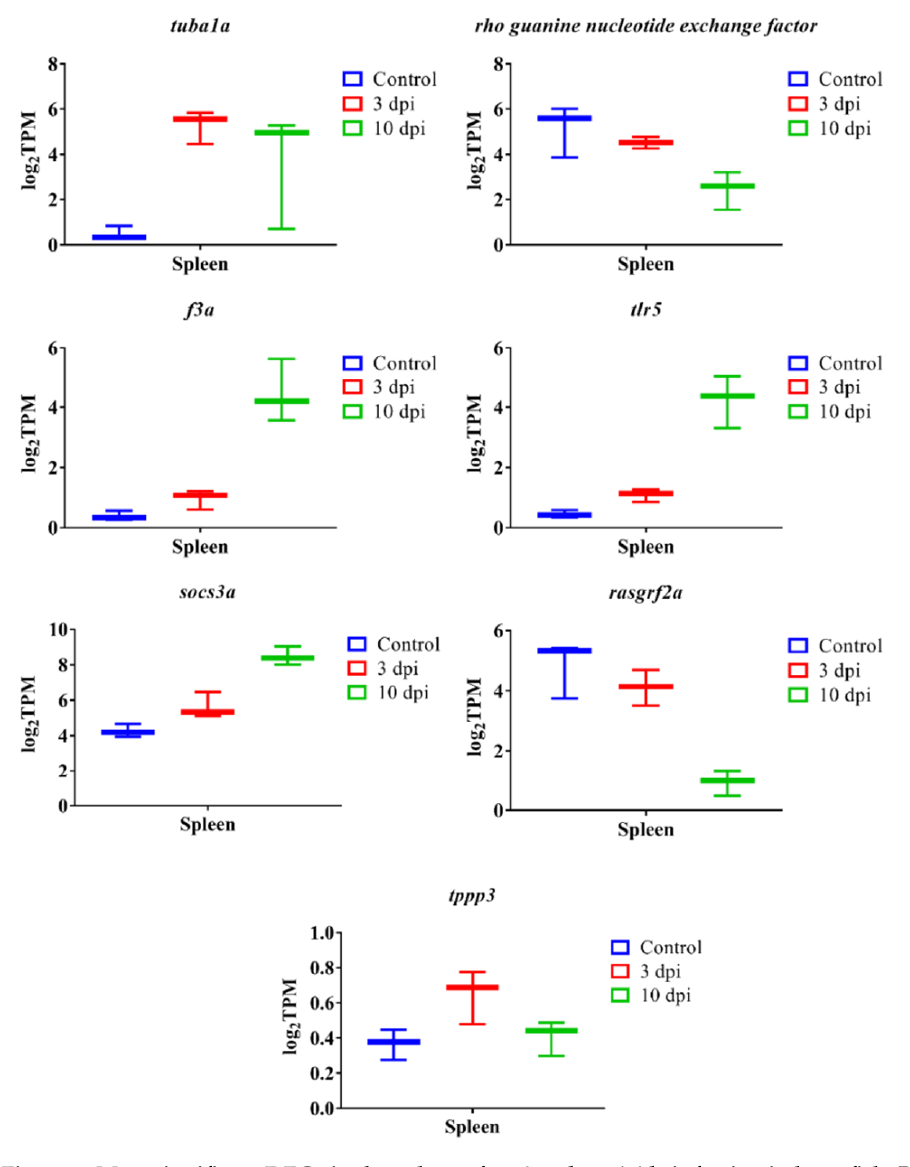
Figure 9. Most significant DEGs in the spleen after A. salmonicida infection in lumpfish. Bar plots represent the expression pattern (log 2 TPM) of tubulin alpha-1A chain (tuba1a), rho guanine nucleotide exchange factor, coagulation factor IIIa (f3a), toll-like receptor 5 (tlr5), suppressor of cytokine signaling 3a (socs3a), ras-specific guanine nucleotide-releasing factor 2a (rasgrf2a), protein family member 3 (tppp3).